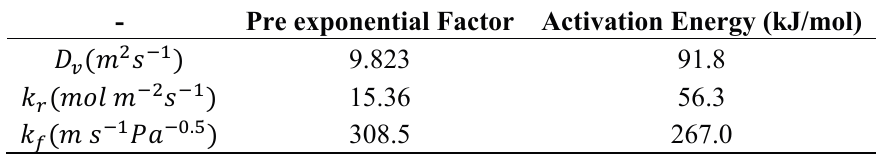
Table 3. Permeability parameters obtained from the data